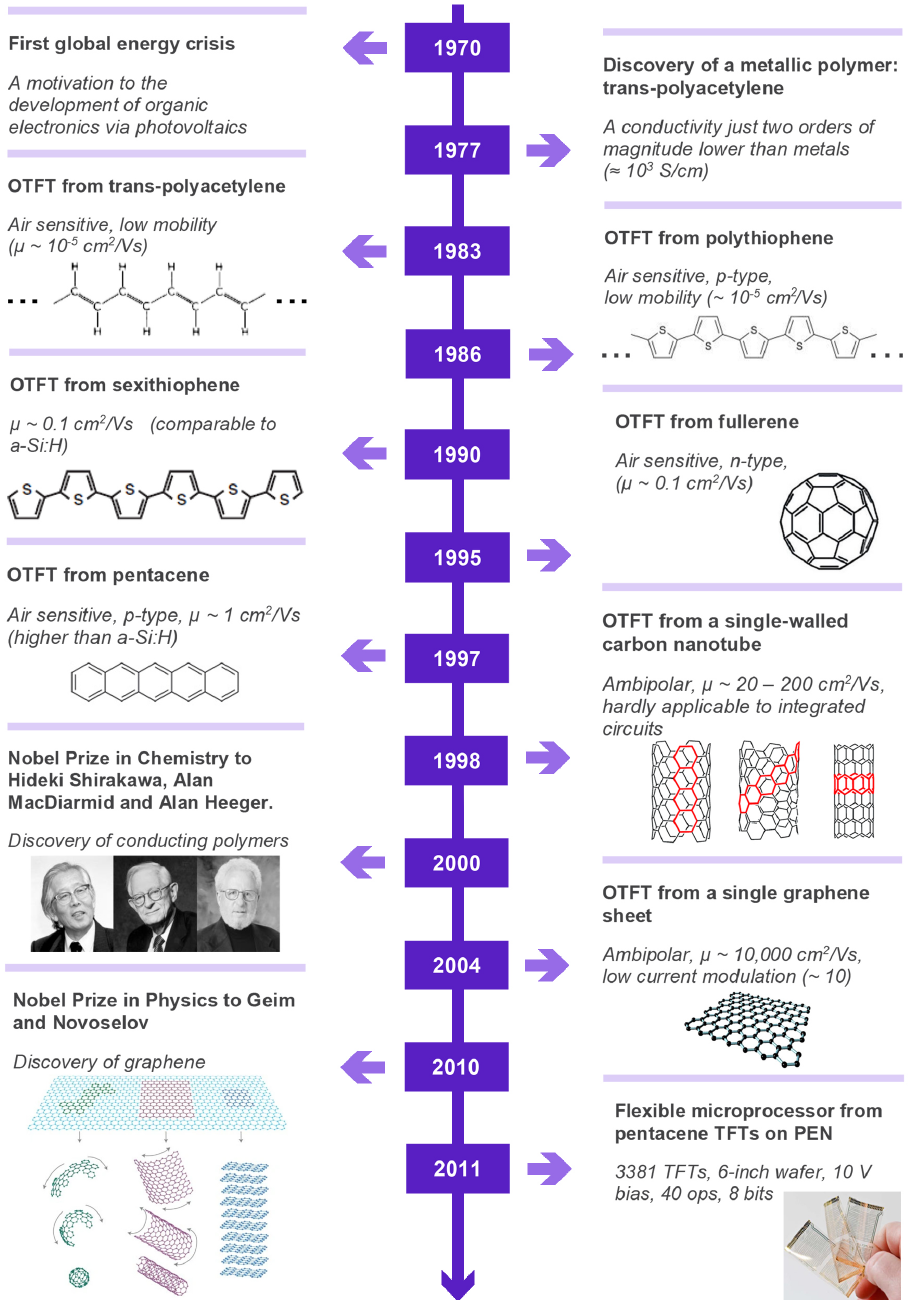
Figure 1. Timeline featuring the main events related to the development of organic electronics. The chemical structures of carbon nanotubes: reprinted from [23]; published by The Royal Society of Chemistry. The chemical structure of graphene: reprinted from reference [29] with permission from Elsevier. Photographs of A. J. Heeger, A. G. McDiarmid and H. Shirakawa 2000 Nobel Prize in Chemistry recipients: reproduced from reference [30] with permission from The Royal Society of Chemistry. Graphene as a 2D building material for carbon materials of all other dimensionalities: reprinted by permission from Springer Nature Customer Service Centre GmbH: Nature, Nature Materials [31], ©2007. The photograph of flexible microprocessors: ©2012 IEEE. Reprinted, with permission, from